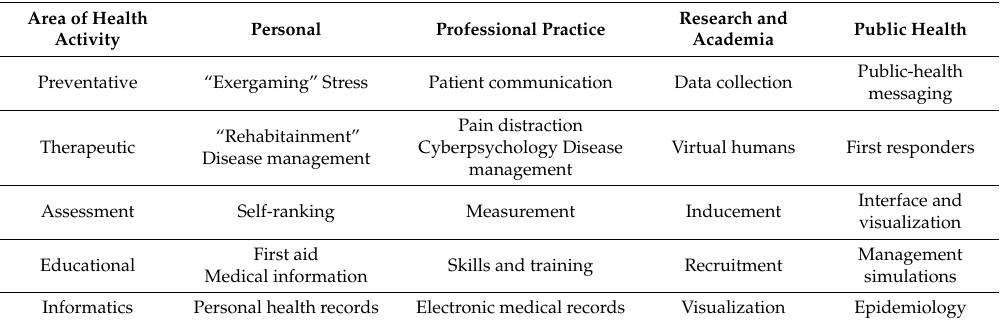
Table 1. Taxonomy of